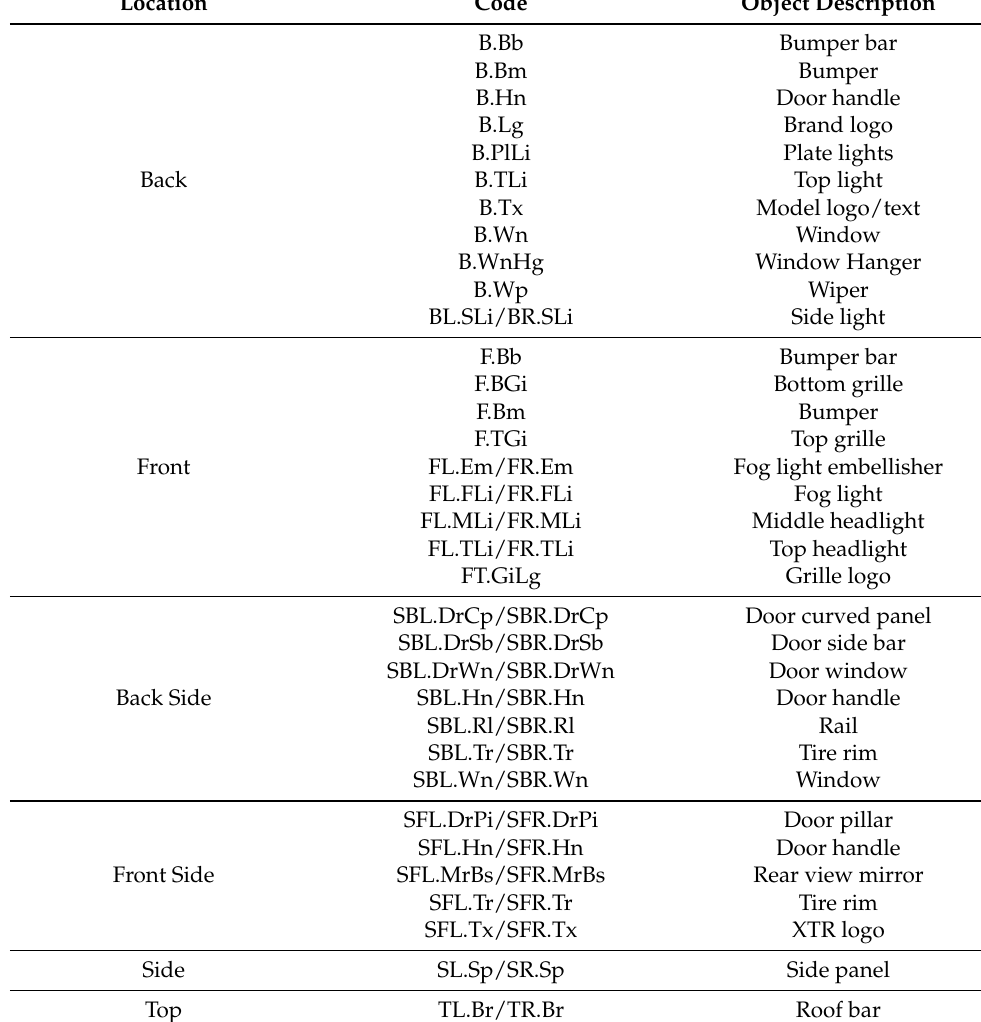
Table A1. Description of every vehicle part code, organized by location. The code is built by combining the location of the object followed by its initials, for example B.Bb is the bumper bar located at the back of the vehicle. The following mapping is used: B—back, F—front, S—side, T—top, M—middle, L—left and R—right. Combinations of the latter can also occur, for example FL—front left or SBR—side back right.